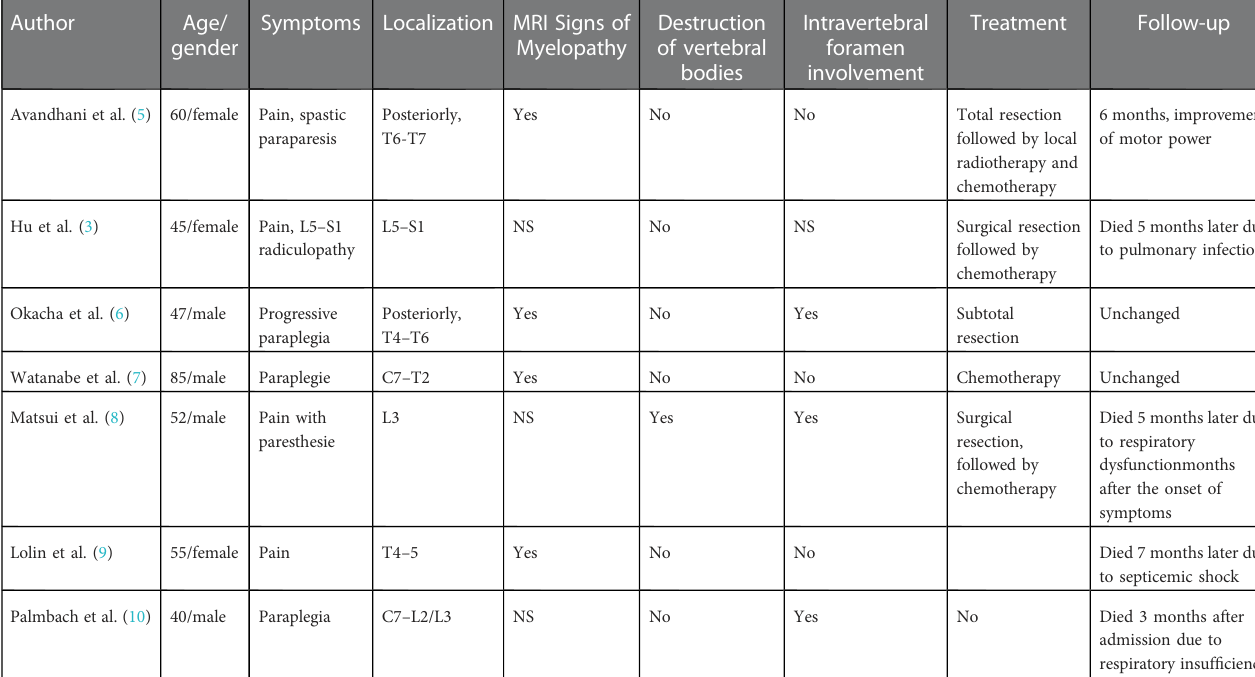
TABLE 1 Published cases of extradural multiple